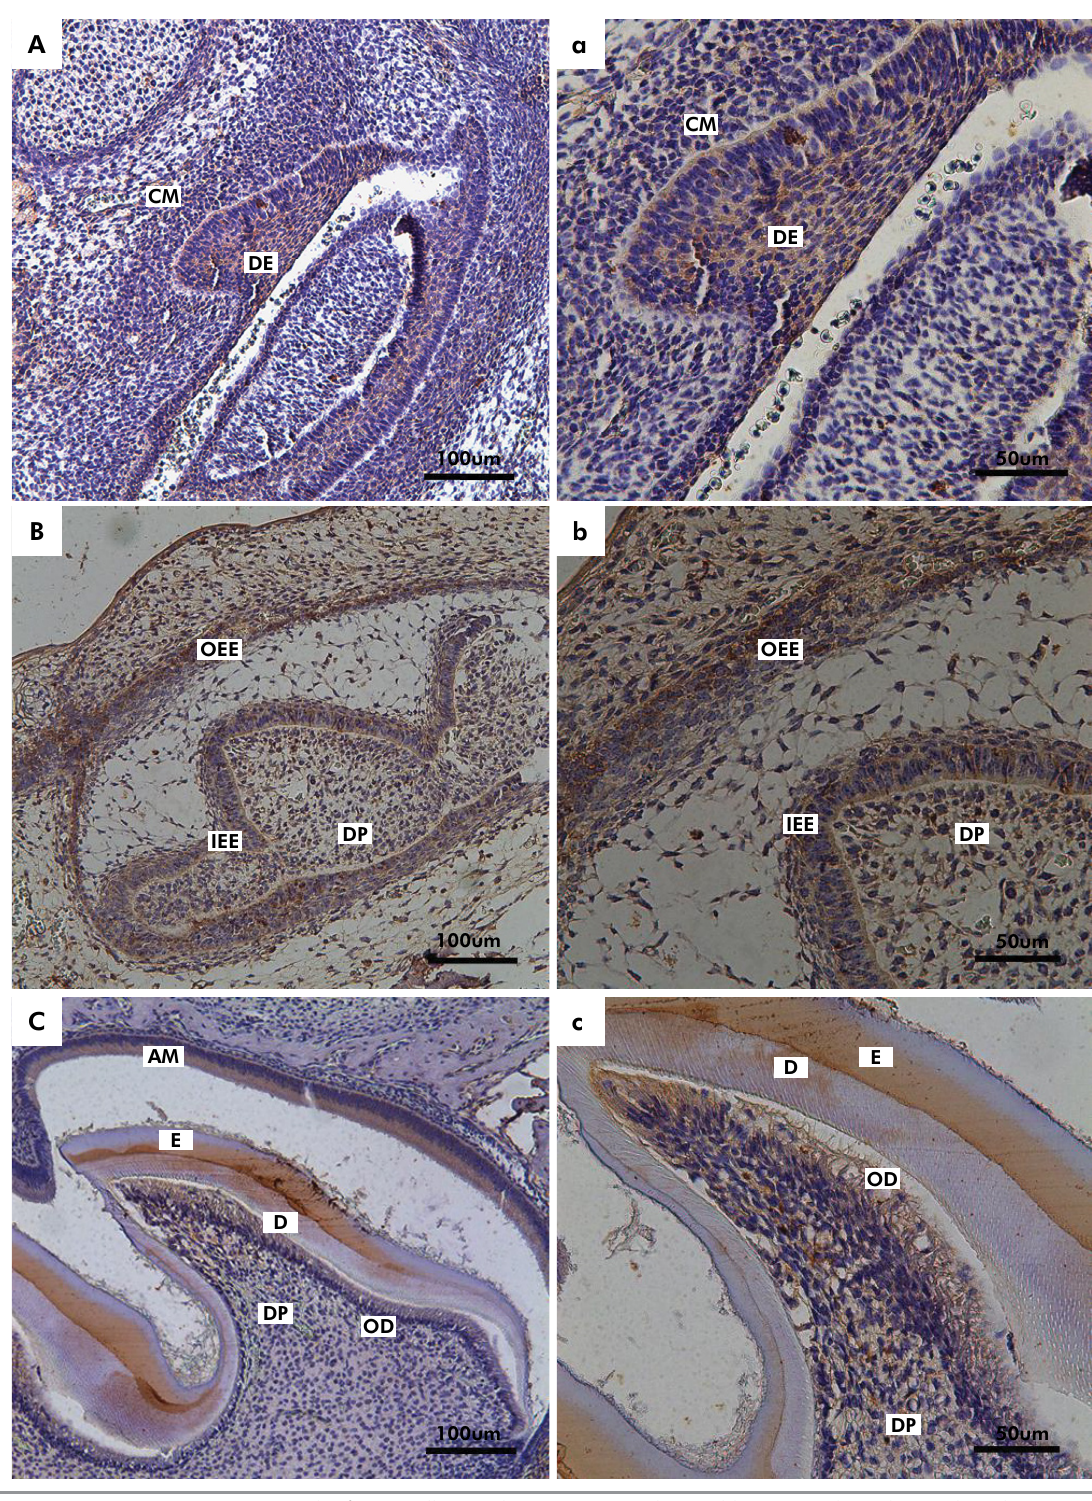
Figure 1. CRABP2 protein expression in the first maxillary molar in mice was detected by immunohistochemical analysis. A and a: CRABP2 was strongly expressed in the dental epithelium during the early bud stage (E13.5). Positive immunolabelling was observed in the basal dental epithelial cells (DE) and surrounding mesenchymal cells (MC). B and b: Positive immunolabelling was also observed in the inner enamel epithelium (IEE), outer enamel epithelium (OEE) and dental pulp (DP) cells (E18.5). C and c: During PN6, CRABP2 was poorly expressed in the odontoblasts (OD) and just several dental DP cells near the OD. (A, B and C: x200; a, b and c: